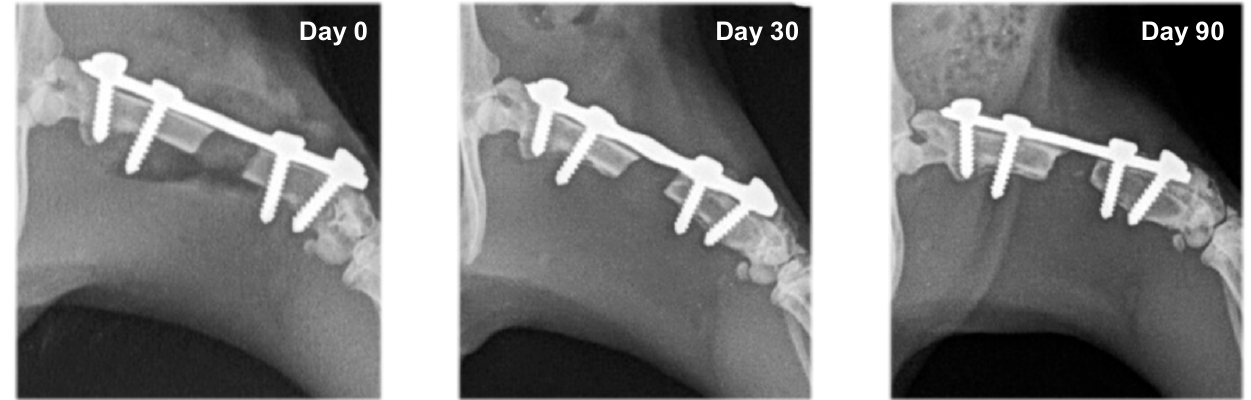
Figure 5. Serial craniocaudal radiographs of rat femurs from experimental group F3 on post-operative days 0, 30 and 90.